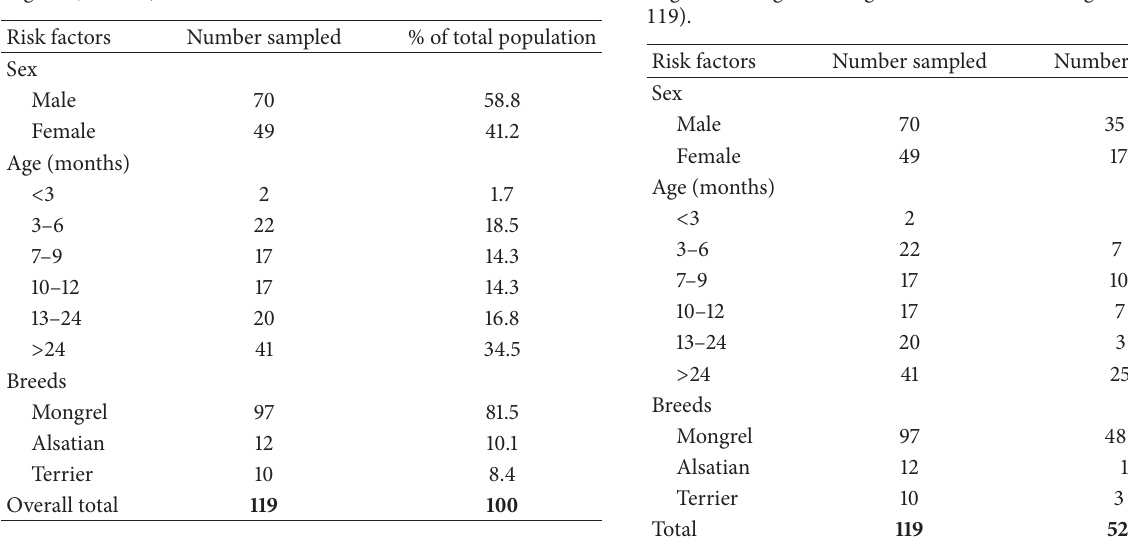
Table 1: Baseline characteristics of the sampled dogs in Maiduguri, Nigeria ( 𝑛 = 119 ).